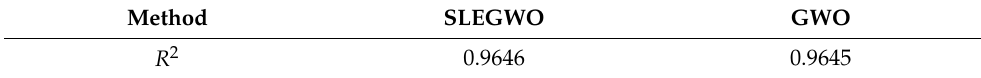
Table 6. The coefficients of determination of fertilizer effect function